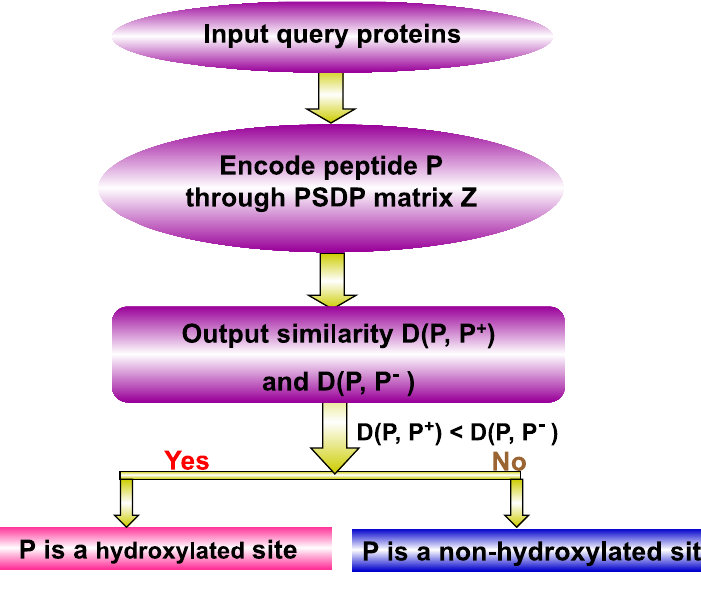
Figure 3. Flowchart to show the process of how the iHyd-PseAAC (identify hydroxylation pseudo amino acid composition) predictor works in identifying the hydroxylated sites in proteins. PSDP, position-specific dipeptide